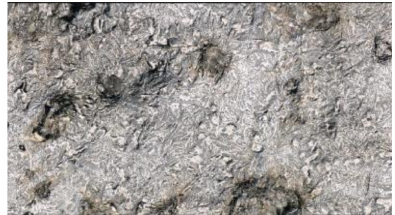
Figure 11. Surface quality W303, magnification 500 × .